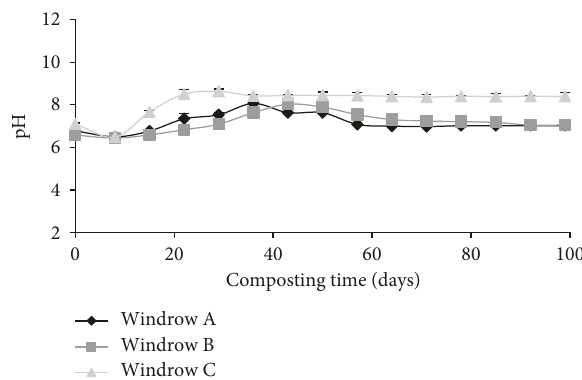
Figure 2: pH evolution during the composting